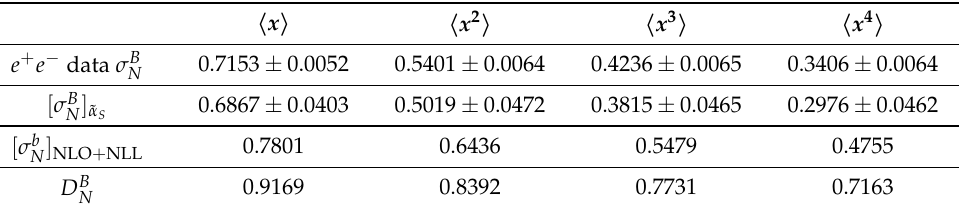
Figure 2. Experimental data on B -hadron production at SLD, OPAL and ALEPH, compared with theoretical calculations carried out in the perturbative fragmentation framework and using either a tuned hadronization model (solid) or an effective coupling constant (dashes) to model non-perturbative corrections. Table 1. Experimental Mellin moments of the B -hadron cross-section from the DELPHI collaboration, along with the moments yielded by the calculation in [22], based on an effective coupling constant, the perturbative moments at NLO+NLL as in [6], and the extracted N -space non-perturbative fragmentation